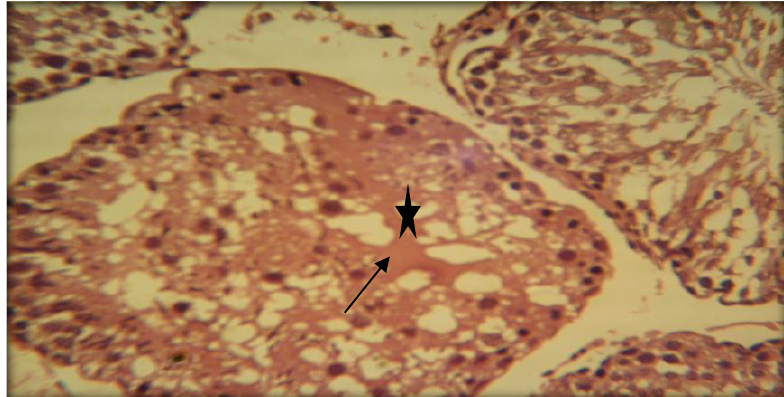
Figure (1): Histological section of rat testis treated with methionine overload (GI).Show degeneration in Sertoli cell ( ) and proteineous material in lumen of seminiferous tubule ( ) (H&E X40).